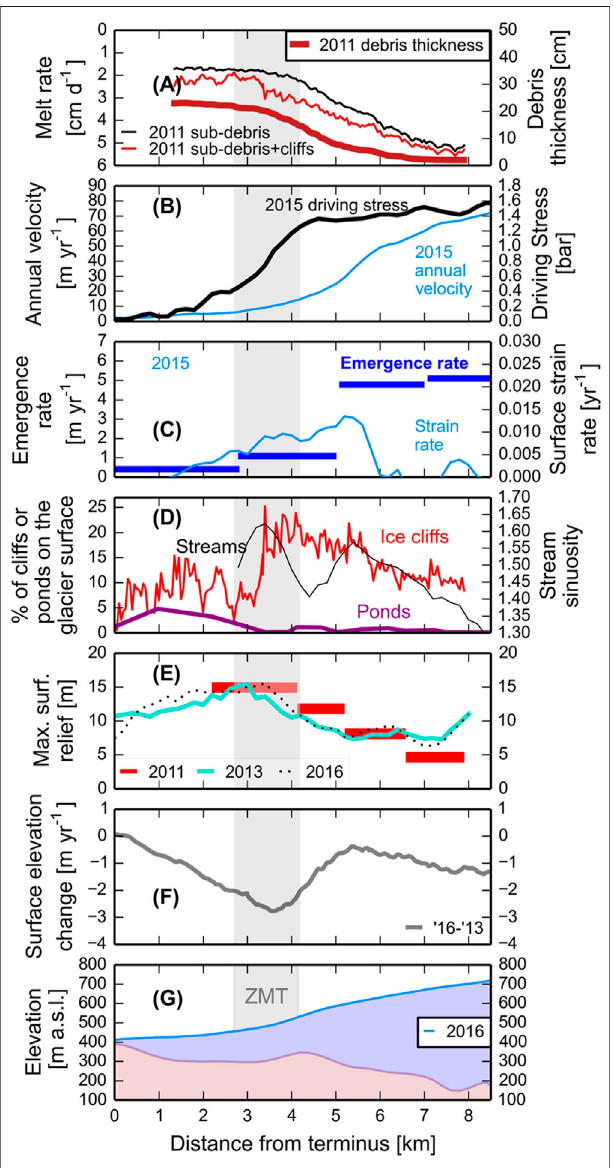
FIGURE 2 | Modern snapshot comparison. The zone of maximum thinning (ZMT) is shown with grey shading. (A) Surface melt rate and debris thicknesspatternsfrom thesummerof2011(Andersonetal.,2021). (B) 2015 annual surface velocity pattern with the driving stress based on the surface slope and ice thickness from 2016. (C) The ice emergence rate averaged over approximately 2 km intervals as well as the surface strain rate from the swath pro fi le, smoothed with a1 kmmoving window. (D) Patternsof melt hotspots, including ice cliffs and stream sinuosity from the swath pro fi le, as well as ponds across the glacier width. (E) Maximum surface relief within the swath pro fi le taken from 2013 (turquoise) and 2016 (black dots) DEMs. Maximum measured ice cliff relief (red) from the glacier surface in 2011 is also shown. (F) The surface elevation change pattern based on fall 2013 and fall 2016 DEMs. (G) Glacier surface elevation and bed topography from 2016 down the glacier centerline.